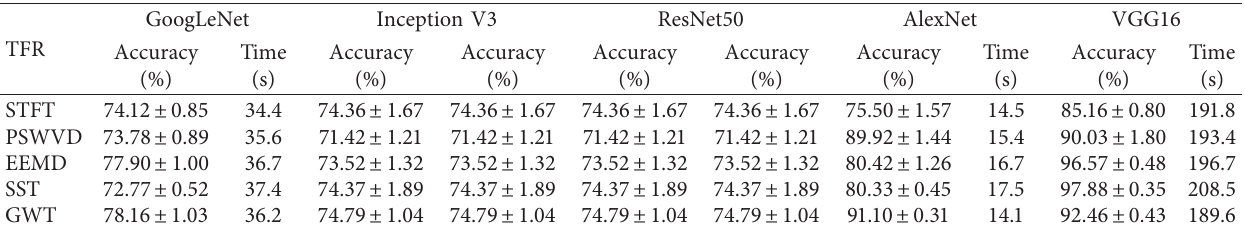
Table 4: Identification accuracy and computational cost for different defect identification